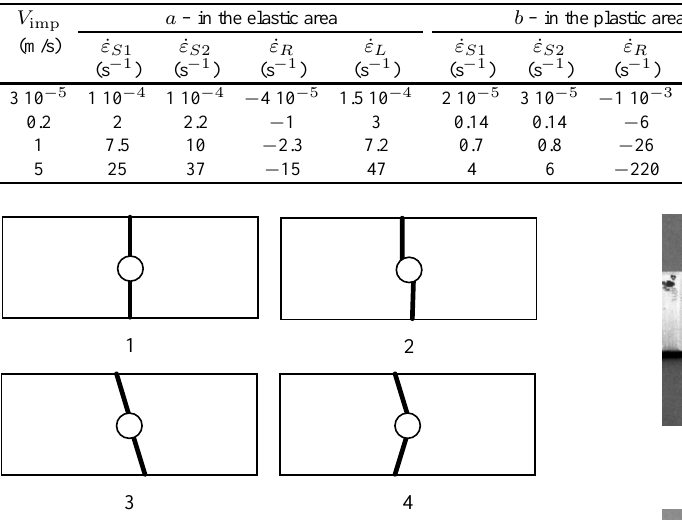
Table 4 Local strain rates of the quasi-static and dynamic tension tests